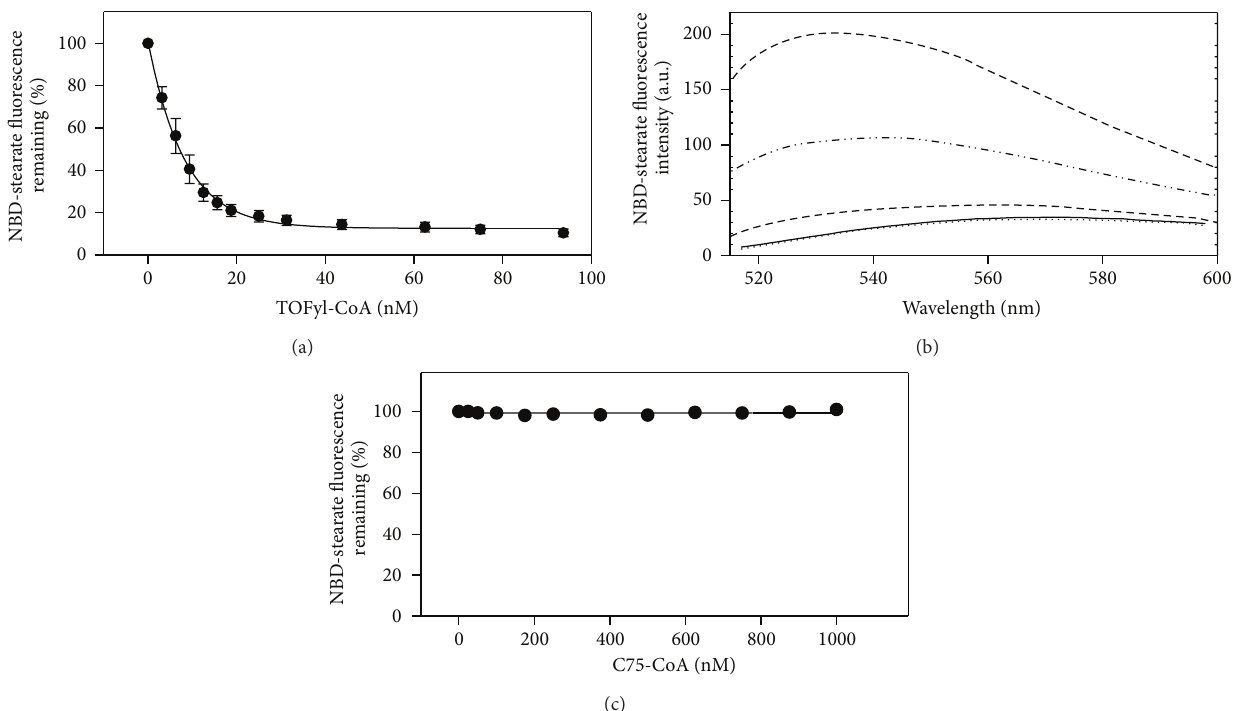
Figure 7: Effect of TOFyl-CoA and C75-CoA on NBD stearic binding to SCP-2. SCP-2 (25nM in 10mM phosphate buffer) was incubated with NBD-stearic acid (40nM) for 12min at 24 ∘ C to obtain maximal fluorescence. The solution was titrated with increasing amount of ligand (TOFyl-CoA or C75-CoA). TOFyl-CoA displaced SCP2-bound NBD stearate (panel a, with representative spectra in panel b). Panel (b), from top to bottom: shot dash line: NBDS+SCP2; dash-double dot-dash line: NBDS+SCP2+TOFyl-CoA (10nM); long dashed line: NBDS+SCP2+TOFyl-CoA (100nM); solid line: NBDS; dotted line: NBDS+TOFyl-CoA (100nM). C75-CoA did not displace SCP2-bound NBD-stearate (panel c). Panel (a), mean ± SEM, 𝑛 = 3